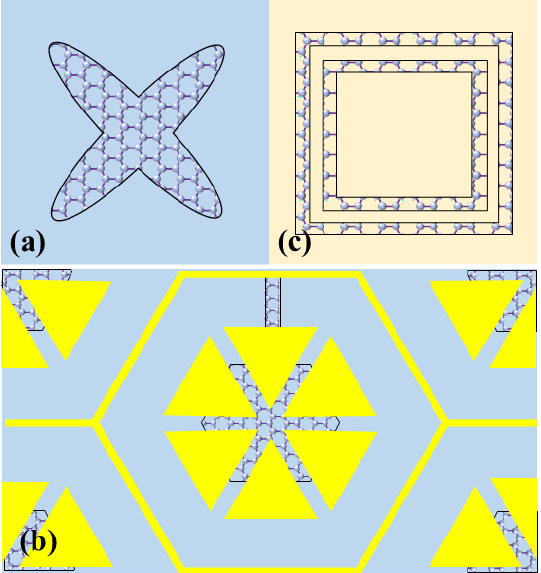
Figure 3. Graphene-based multi-band terahertz metamaterial absorbers using discrete graphene microstructures. ( a ) cross-elliptical graphene pattern [37]; ( b ) hybrid graphene-gold structure [50]; ( c ) double graphene square ring. Adapted with permission from Ref. [51], 2019, Copyright The author.